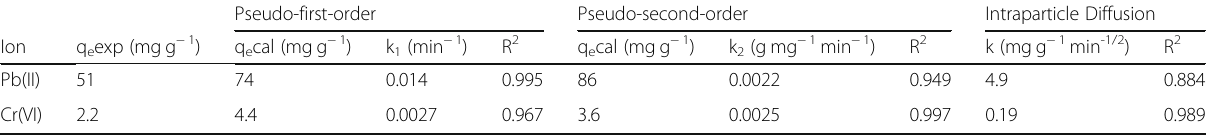
Table 1 Kinetic parameters for the adsorption of Pb(II) and Cr(VI) ion onto CSM/SA hybrid beads Pseudo-first-order